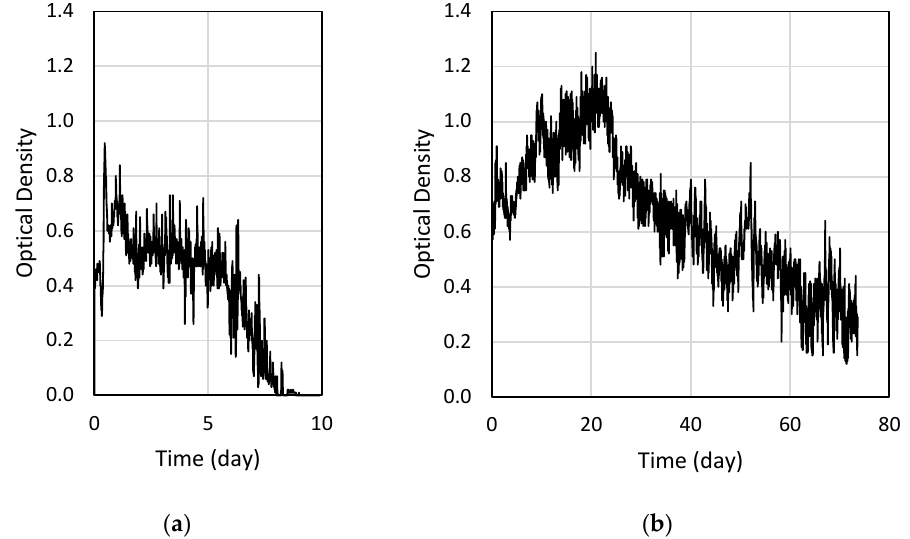
Figure 2. Optical density (OD) changes in ( a ) dark and ( b ) light conditions with time.